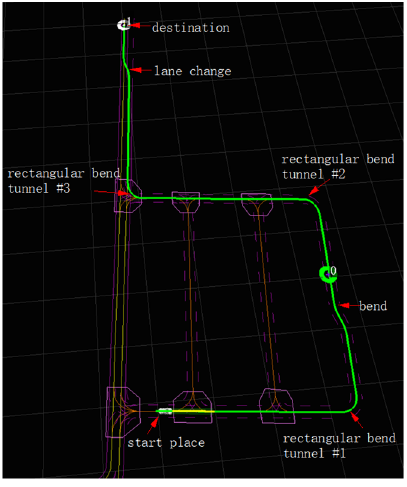
Figure 7. Test path.